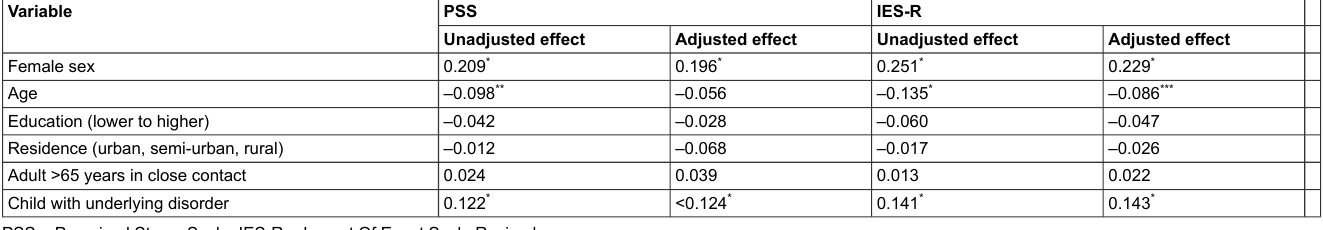
Table 2: Determinants of PSS and IES-R